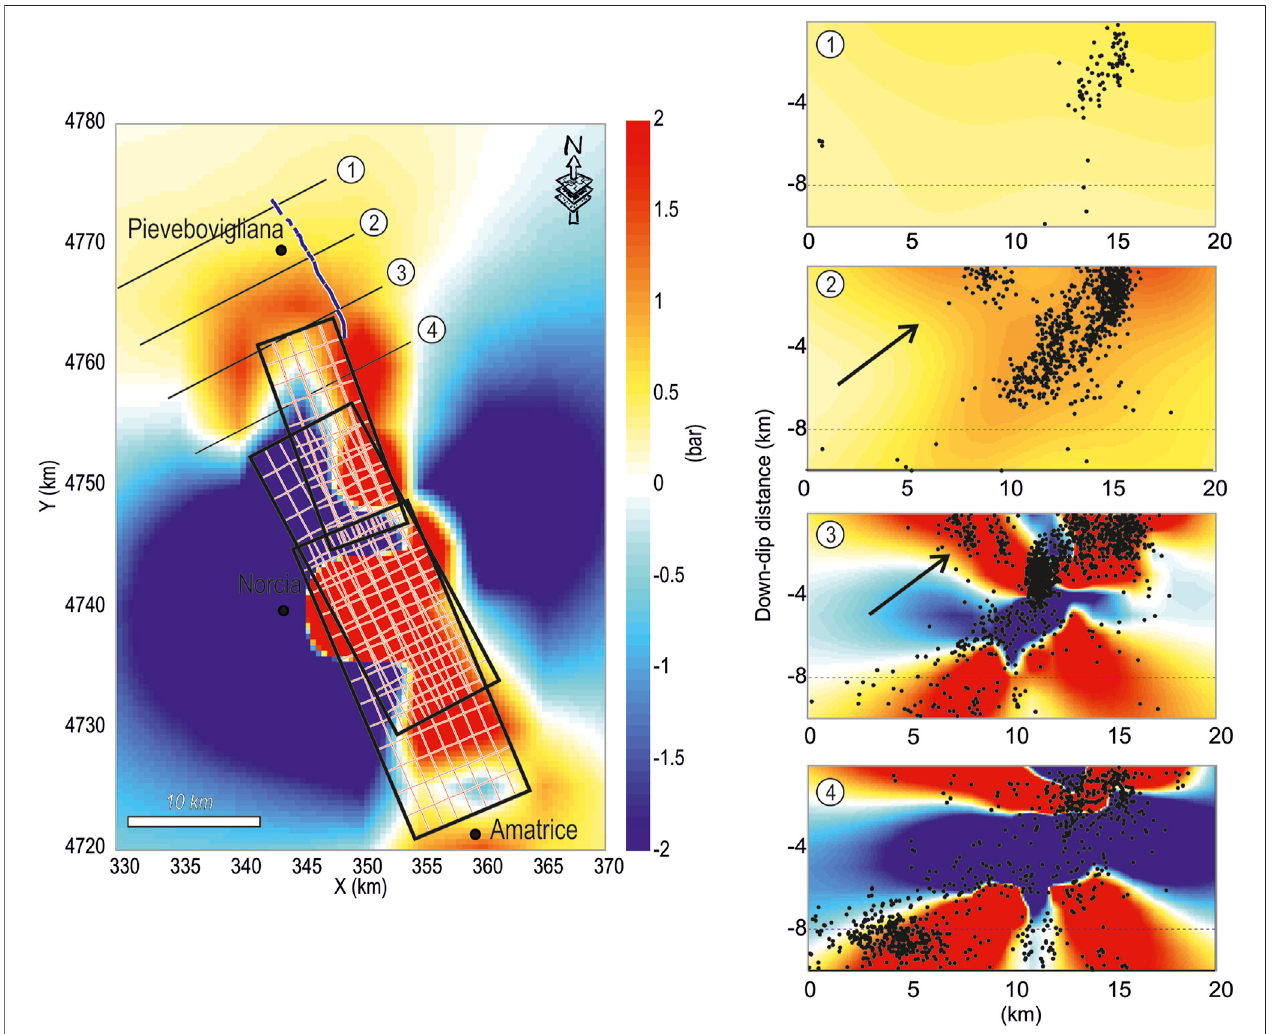
FIGURE 11 | Map and cross-sections of cumulative Coulomb stress changes, imparted by EQ1, EQ2 and EQ3, on a generic plane compatible with the main fault alignment, computed with heterogeneous slip models (Chiaraluce et al., 2017) at a depth of 8 km and along the geological cross-sections. On the map, the black rectangles represent the modeled fault planes and the red ones the sub-faults. The number 1 – 4 refer to geological cross-sections. The blue line on the map represents thefaulttraceofthereconstructedPieveboviglianafault.TheblackarrowsindicatethevolumeintowhichseismicitymigratedduringApril-May2018.Theblackdots along the cross-sections are the locations of aftershocks computed by Chiaraluce et al. (2017) occurring from 2016/08/24 to 2016/11/30 and projected on the cross- sections considering a half-width of 2.5 km.